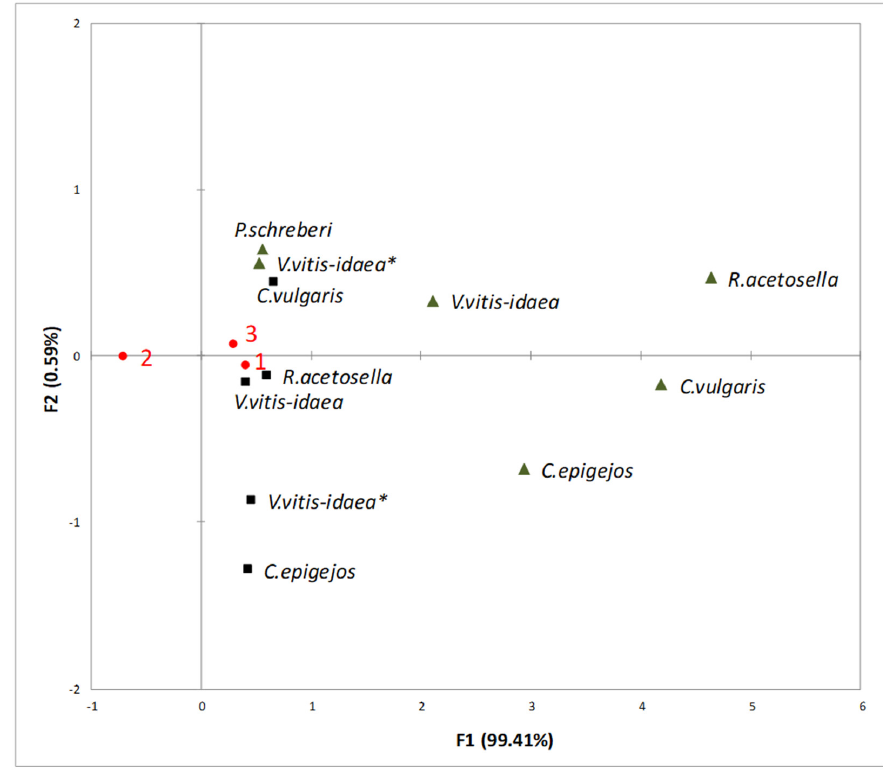
Figure 5. RDA of the impact of the shoots (black triangles) and roots (black squares) of plant-donor aqueous extracts on hypocotyl length at different climate conditions (1—Current environmental conditions (21.5/16 ◦ C and 400 ppm CO 2 concentration), 2—temperature increases of 4 ◦ C compared to the current conditions (25.5/20 ◦ C and 400 ppm CO 2 concentration), 3—increasing temperature with higher CO 2 concentration conditions (25.5/20 ◦ C and 700 ppm CO 2 ). (*): dominant species of 2-year-old clear-cuts. Table 2. Overall difference between treatment groups and between the treatments ( n = 9) for radicle and hypocotyl